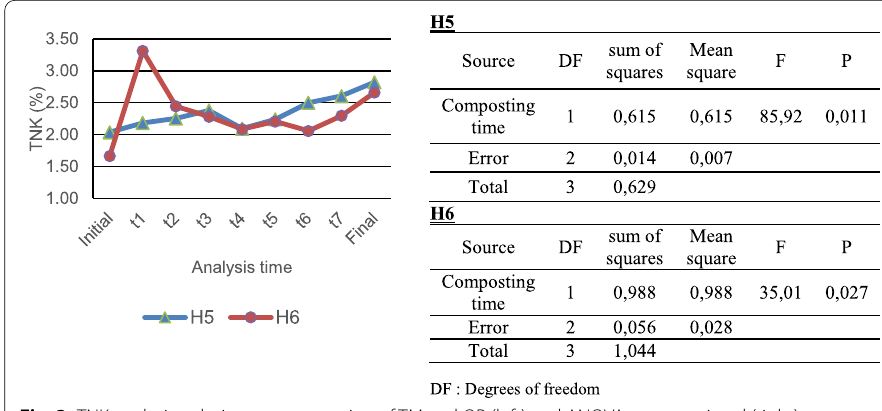
Fig. 3 TNK evolution during co‑composting of TM and OP (left) and ANOVA test associated